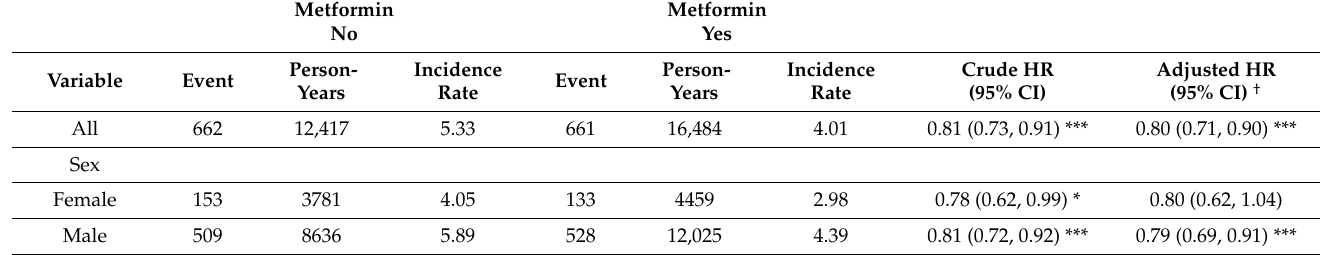
Table 2. Incidence density of deaths due to nasopharyngeal cancer between Metformin use group and non-Metformin use